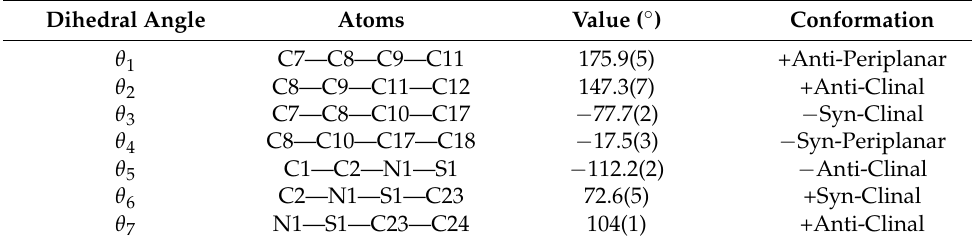
Table 2. Selected dihedral angles for